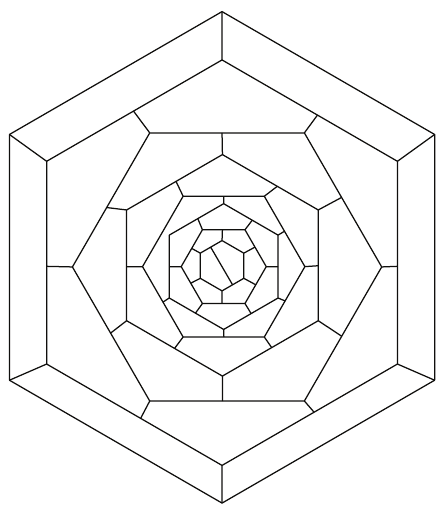
Figure 4: The molecular structure of fullerenes 𝐶 12𝑛+4 . Table 3: Some exceptional cases of reverse eccentric connectivity index of fullerenes 𝐶 12𝑛+4 .